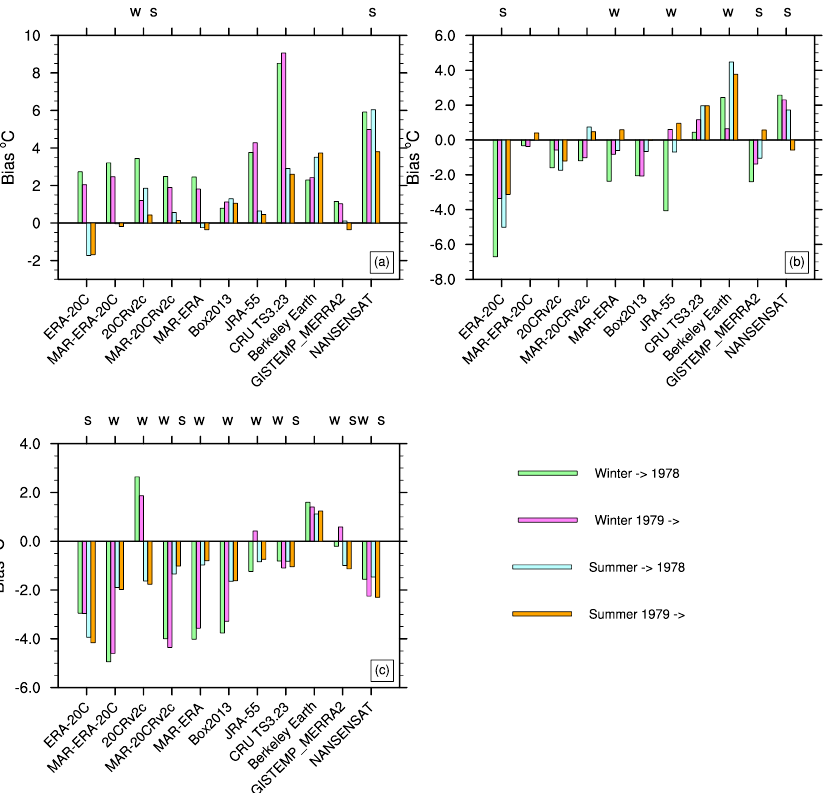
Figure 5. Monthly mean SAT bias for winter (DJF) and summer months (JJA) before and after 1979, for all datasets that extend back before 1979 (elevation-corrected where applicable) at: ice sheet stations above 1500m (a) ; ice sheet stations below 1500m (b) ; and coastal (DMI) stations (c) . Note that these are monthly SAT biases averaged over all months in a season, not biases of seasonal mean SAT. Changes significant at the 99% level (using Student’s t test with unequal variances) are denoted by w (for winter) and s (for summer) on the top